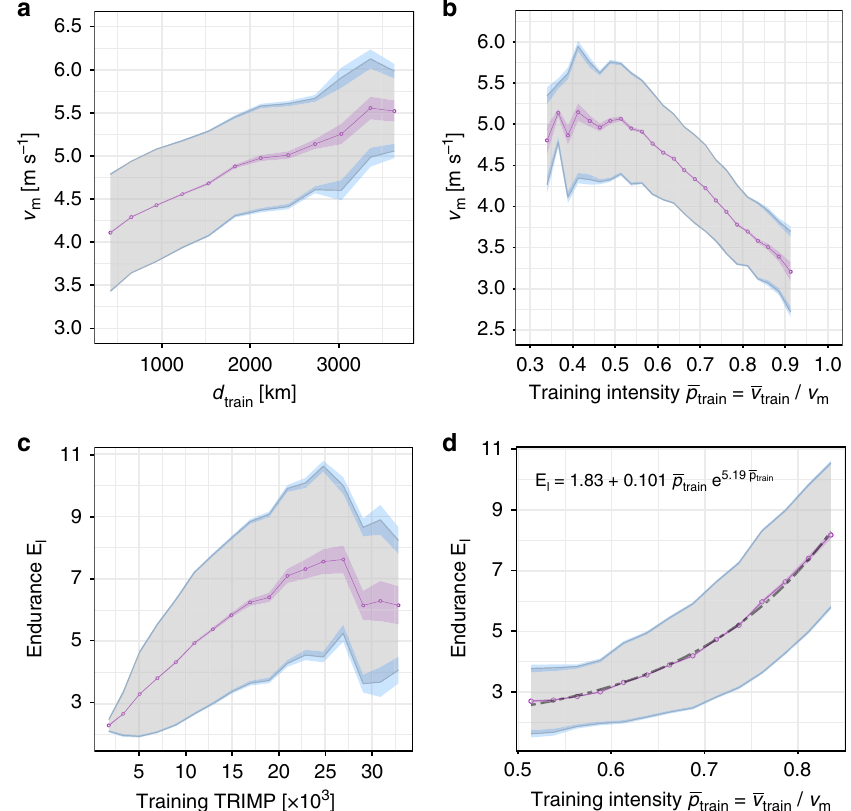
Fig. 5 Correlations between performance indices and training characteristics. We have measured the distance and time for each running activity during a training season for a total number of 21,605 seasons. The graphs show the observed relations between performance indices (obtained from a model fi t to the racing season) and different measures of training volume and intensity. The magenta line indicates the average, the gray region one standard deviation, and the light magenta and blue shaded areas represent the standard error of the mean and standard deviation, respectively, as obtained from bootstrap resampling with replacement (see “ Methods ” section for more details). a Increase of crossover velocity v m with total distance d train of training runs. b Relation between crossover velocity v m and relative training intensity p train ¼ (cid:1) v train = v m where (cid:1) v train is the average training velocity. c Increase and saturation of endurance E l with training impulse (TRIMP). d Exponential growth of endurance E l with relative training